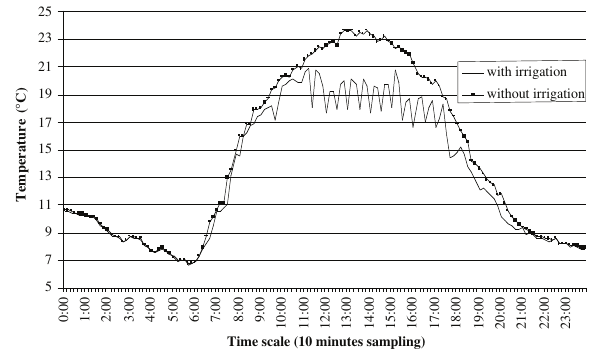
Figure 6. The effect of daytime irrigation on the daily distribution of temperature on the day when the wind speed was lower than 3m/s, and the relative humidity less than 50% at noon- in pear plantation. 23rd of April 201.